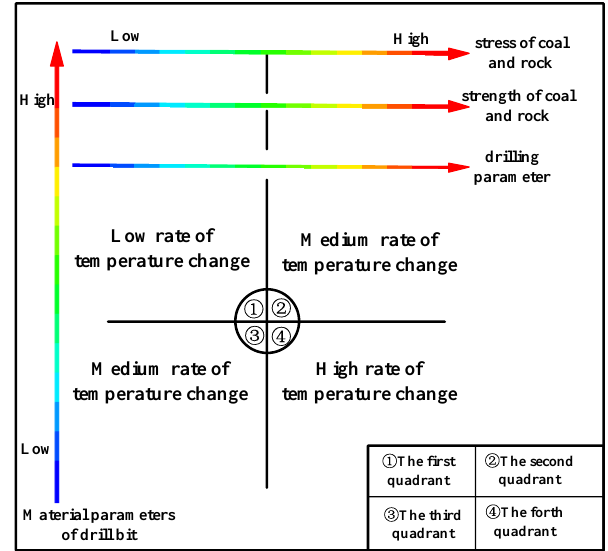
Figure 1. Diagram of the relationship between the rate of temperature change of the bit and the influencing factors.